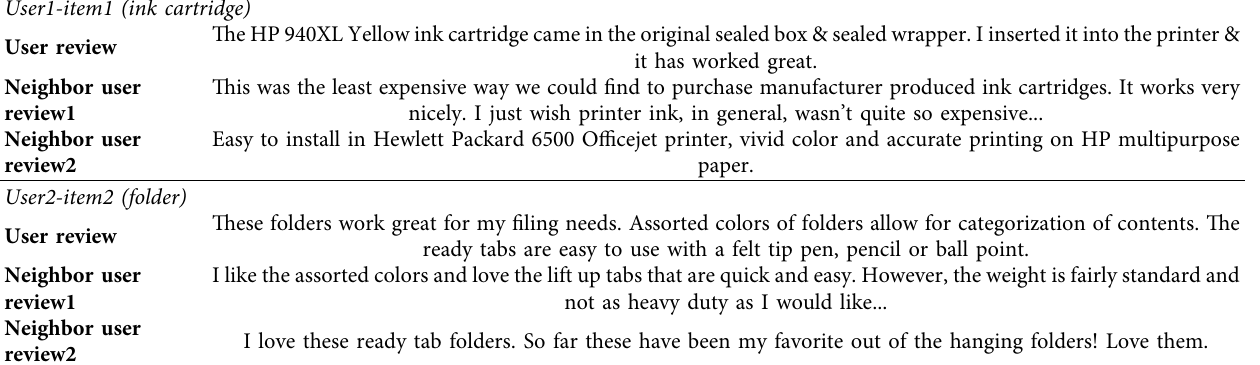
Table 5: Case study of two user-item pairs from office